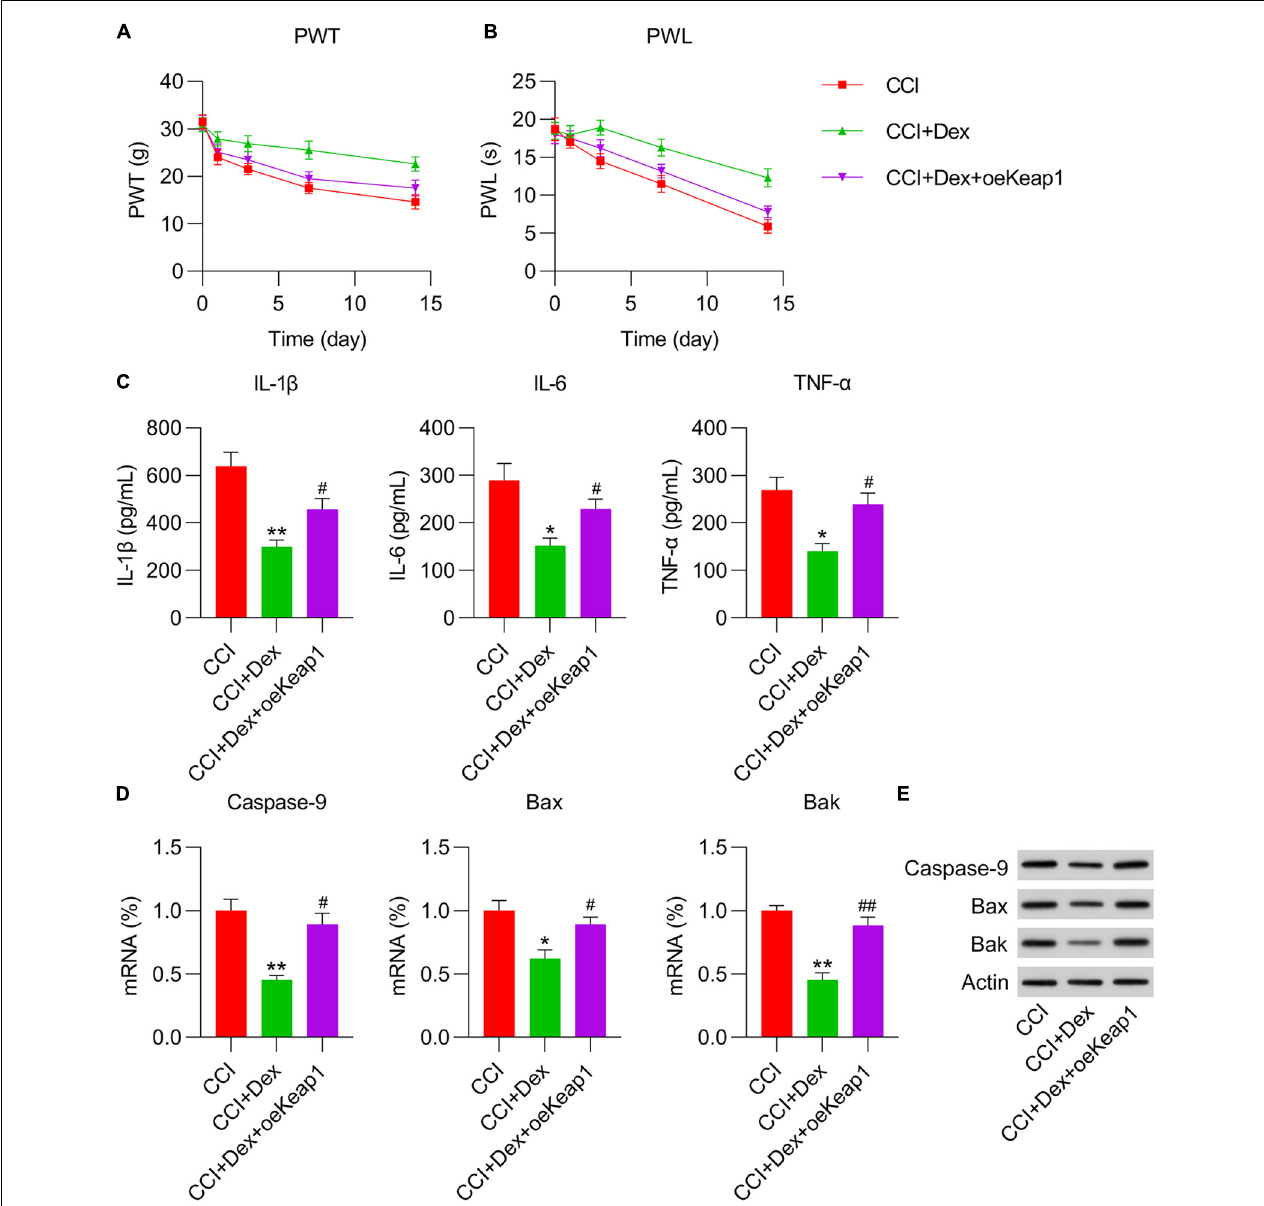
FIGURE 5 | Effect of Keap1 overexpression on Dex-alleviated neuropathic pain in CCI-induced rats intrathecally injected with lentiviral-NC/lentiviral-Keap1 for 1 week. Rats were then subjected to Dex treatment and CCI surgery. (A) Paw withdrawal threshold (g) at 0, 1, 3, 7, and 14 days after operation. (B) Paw withdrawal latency (s) at 0, 1, 3, 7, and 14 days after operation. (C) IL-1 β , IL-6, and TNF- α expression levels were measured in spinal cord tissues using ELISA. (D) mRNA expression levels of caspase-9, Bax, and Bak were determined in spinal cord tissues using quantitative polymerase chain reaction. (E) Protein expression levels of caspase-9, Bax, and Bak in spinal cord tissues were determined using western blotting. * P < 0.05, ** P < 0.01 vs. CCI group; # P < 0.05, ## P < 0.01 vs. CCI + Dex group.